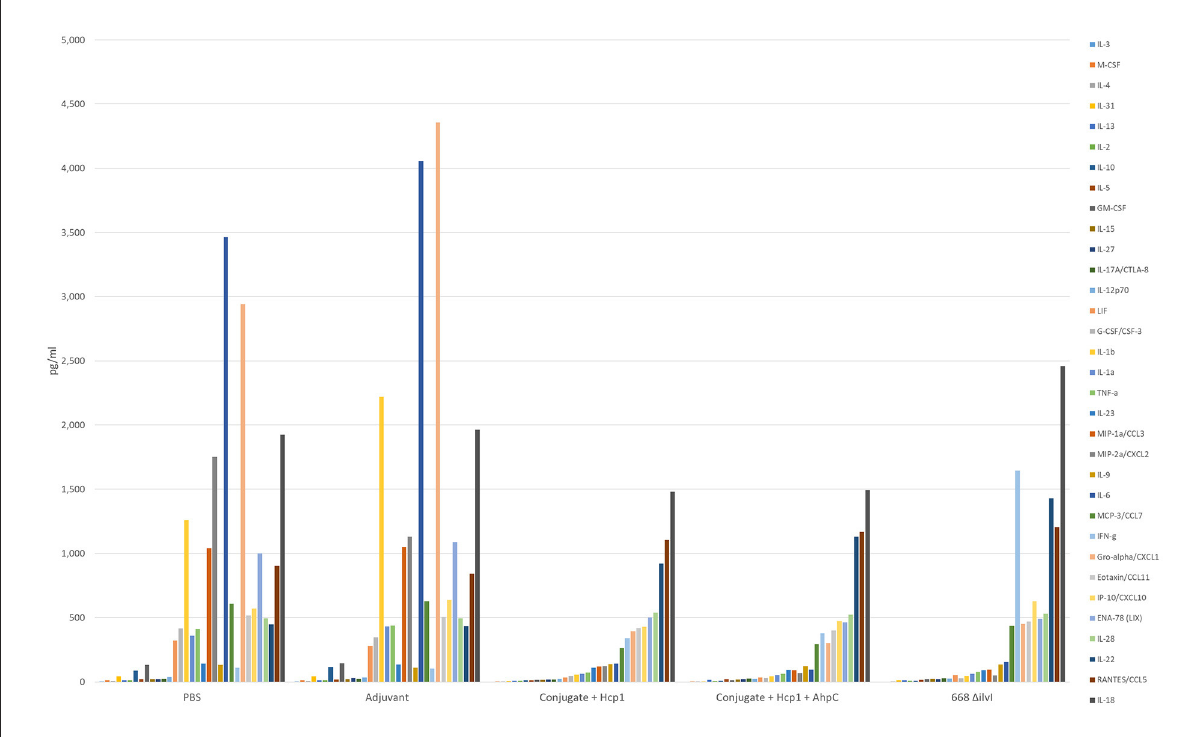
FIGURE4 Cytokine analysis of lung homogenates from vaccinated mice collected 3 days after challenge with a 3.4 LD 50 dose of Bp K96243. Cytokine levels are depicted as pg/ml homogenate